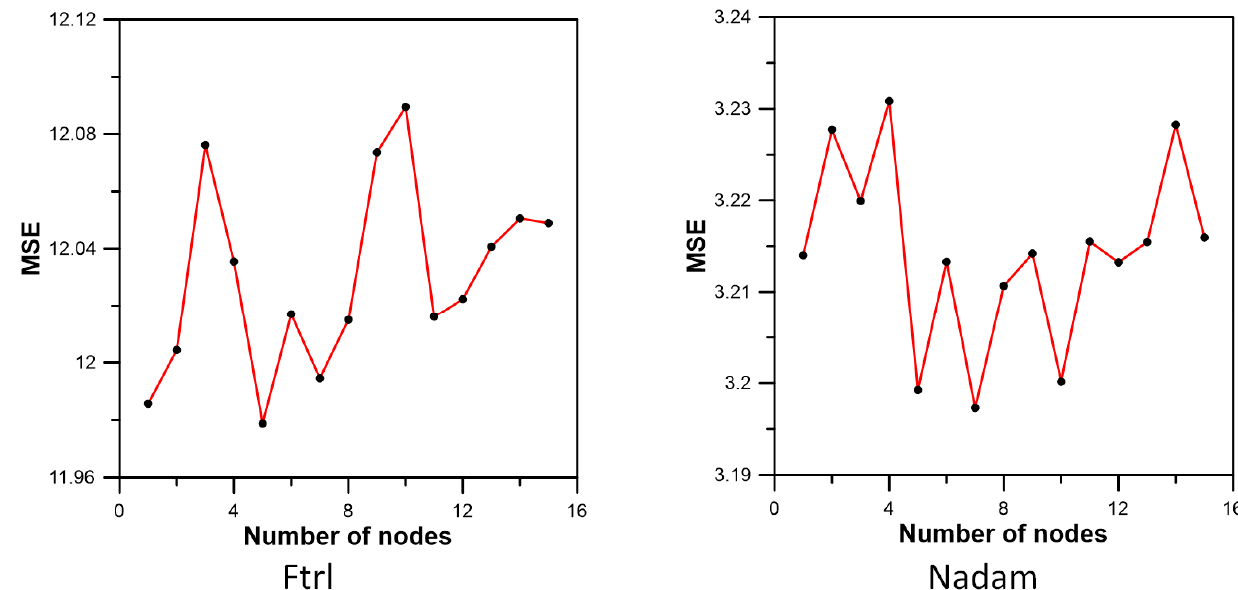
Figure 17. Results according to the number of hidden layers (Ftrl and Nadam).